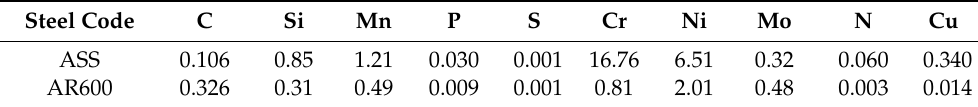
Table 1. Chemical composition (%) of the base metals.